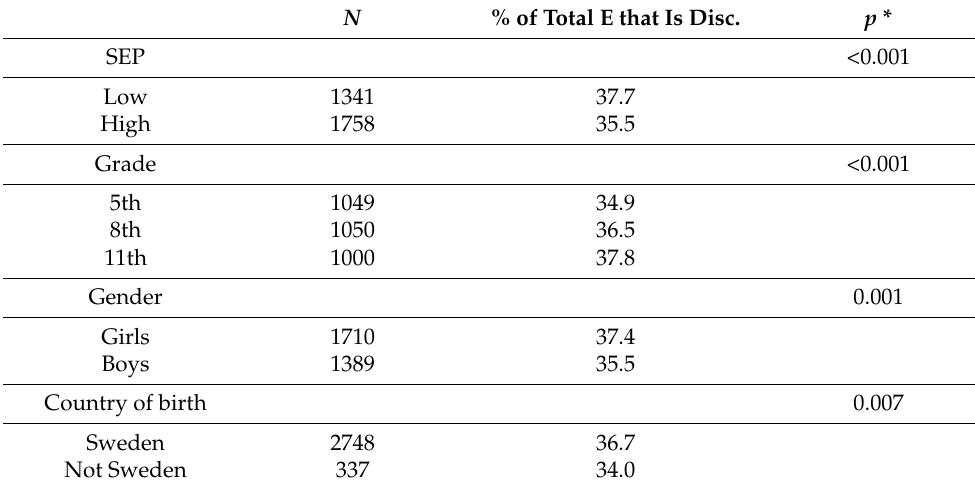
Table 2. Discretionary intake according to sociodemographic factors. N % of Total E that Is